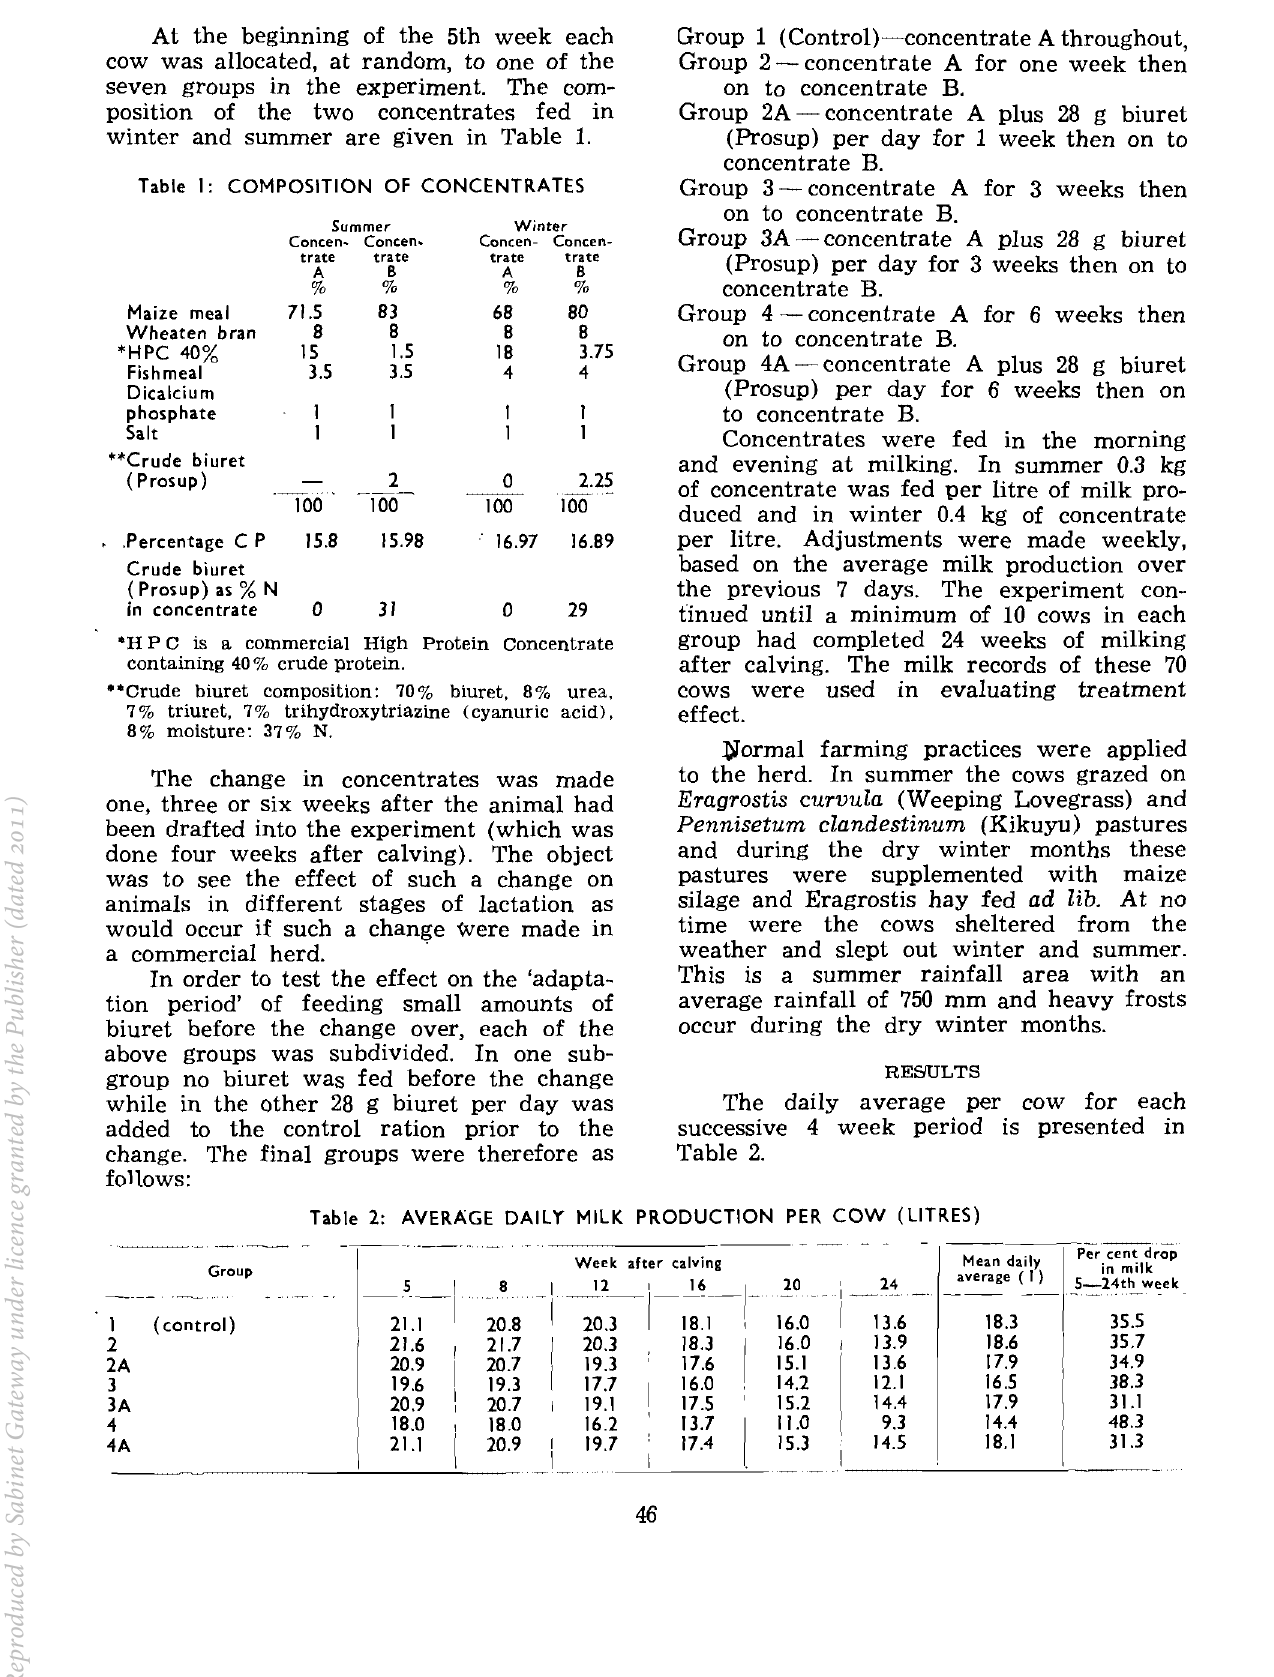
Table I: COMPOSITION OF CONCENTRATES